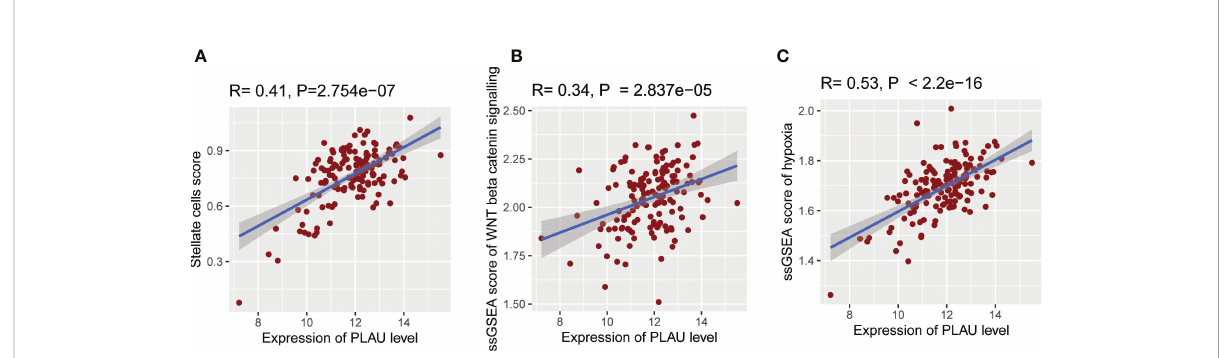
FIGURE 6 Association of PLAU gene expression with abundant activated PSCs and pathways responsible for PSC-PC interactions. In the TCGA PDAC cohort, u pregulation of PLAU gene expression exhibit a signi fi cant positive association with (A) abundance of activated PSCs in the TME (R=